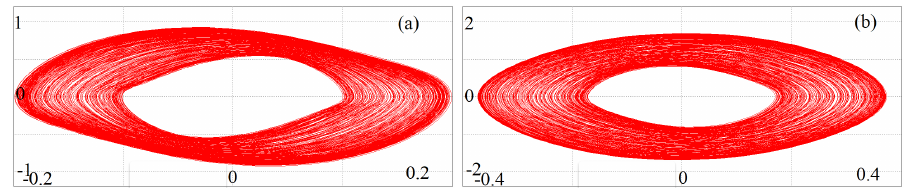
Figure 21. Phase-space diagrams of the circuit when f = 13.044 kHz. The corresponding ω nd = 4.098. ( a ) x -axis is the voltage of y 1 in V and y -axis is the voltage of z 1 in V, ( b ) x -axis is the voltage of y 2 in V and y -axis is the voltage of z 2 in V. The initial condition has been chosen at (0.333,0,0,0) to obtain the phase portraits. (Color